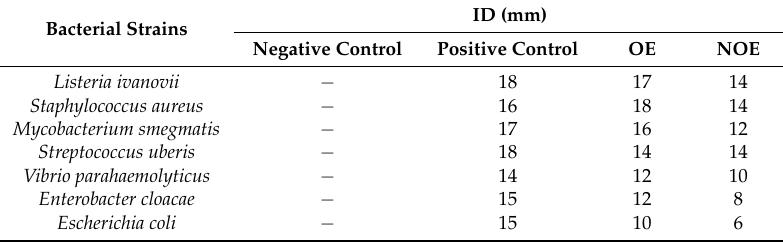
Table 6. The antimicrobial activity of optimized and non-optimized extracts from mangosteen pericarp; ID: diameter of inhibition